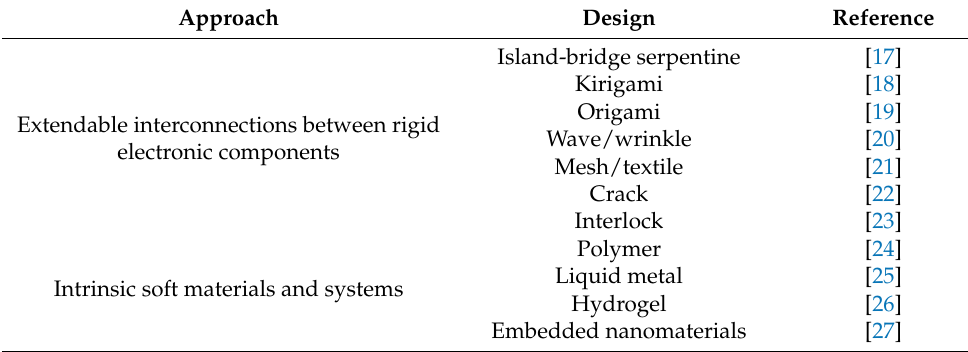
Table 2. Summary of designs for achieving softness in wearable